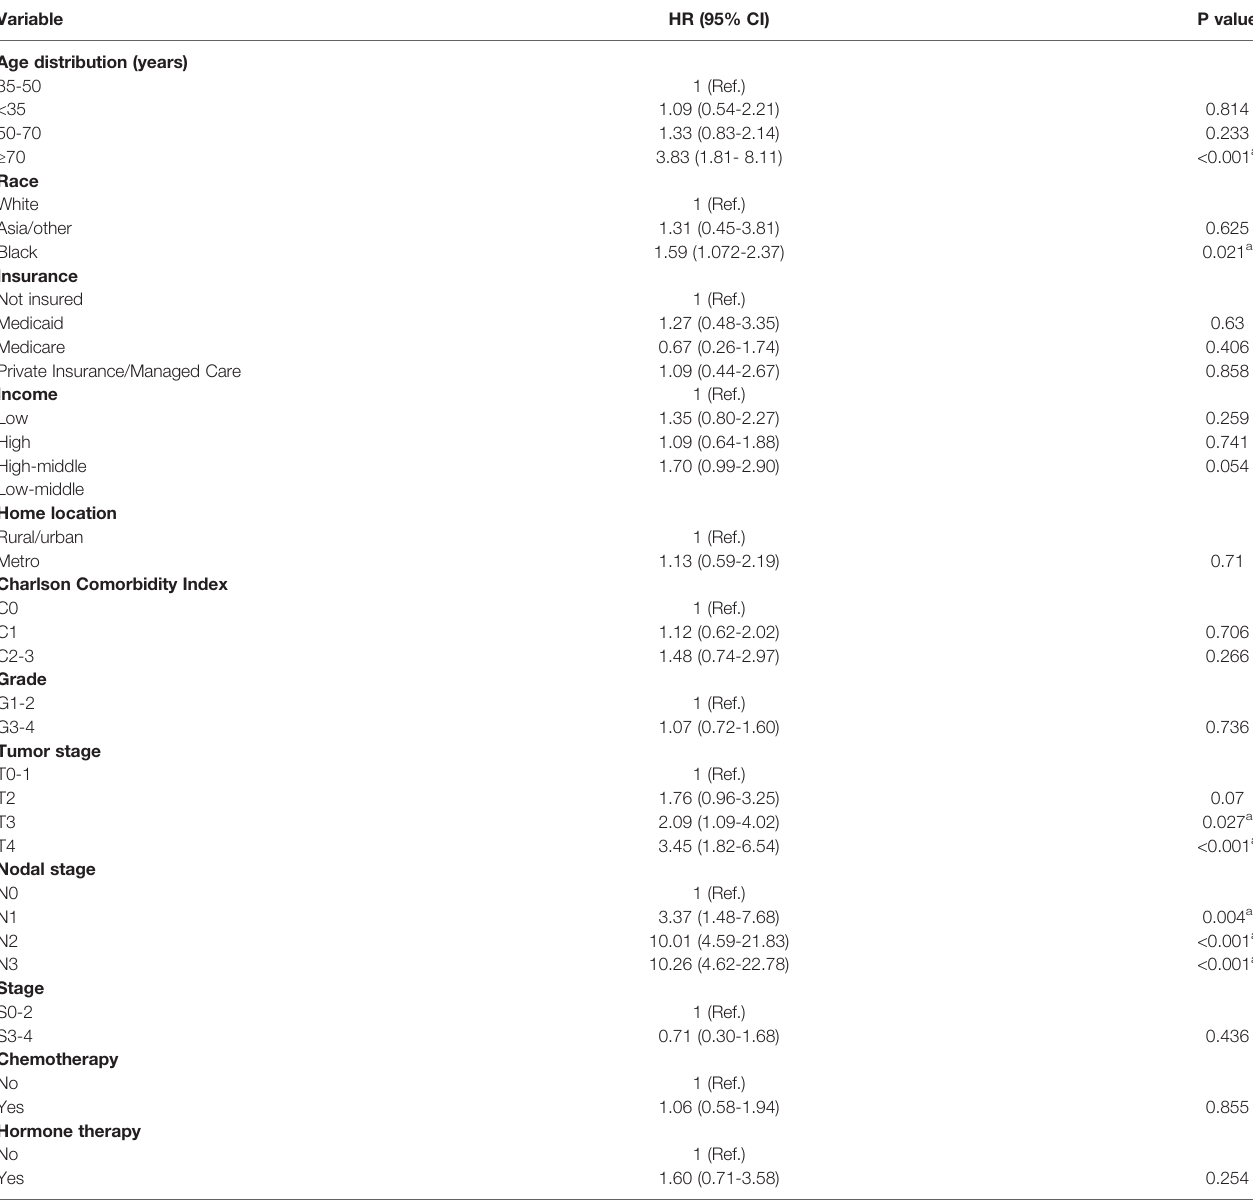
TABLE 3 | Propensity-adjusted multivariable Cox regression analysis of overall survival for locally advanced breast